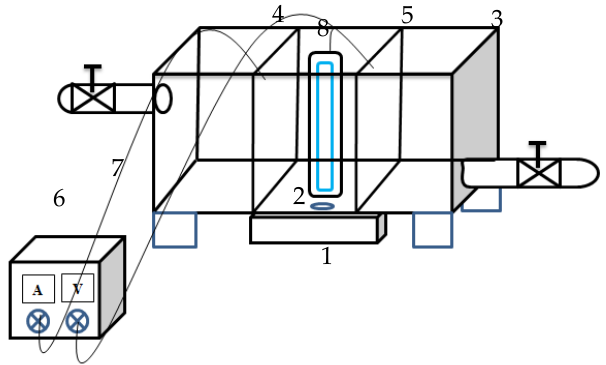
Figure 1. Schematic representation of an electrocoagulation reactor. 1: stirrer, 2: magnet, 3: ECP cell, 4: anode, 5: cathode, 6: power supply, 7: wires, 8: UV-LED chipset (280 nm).